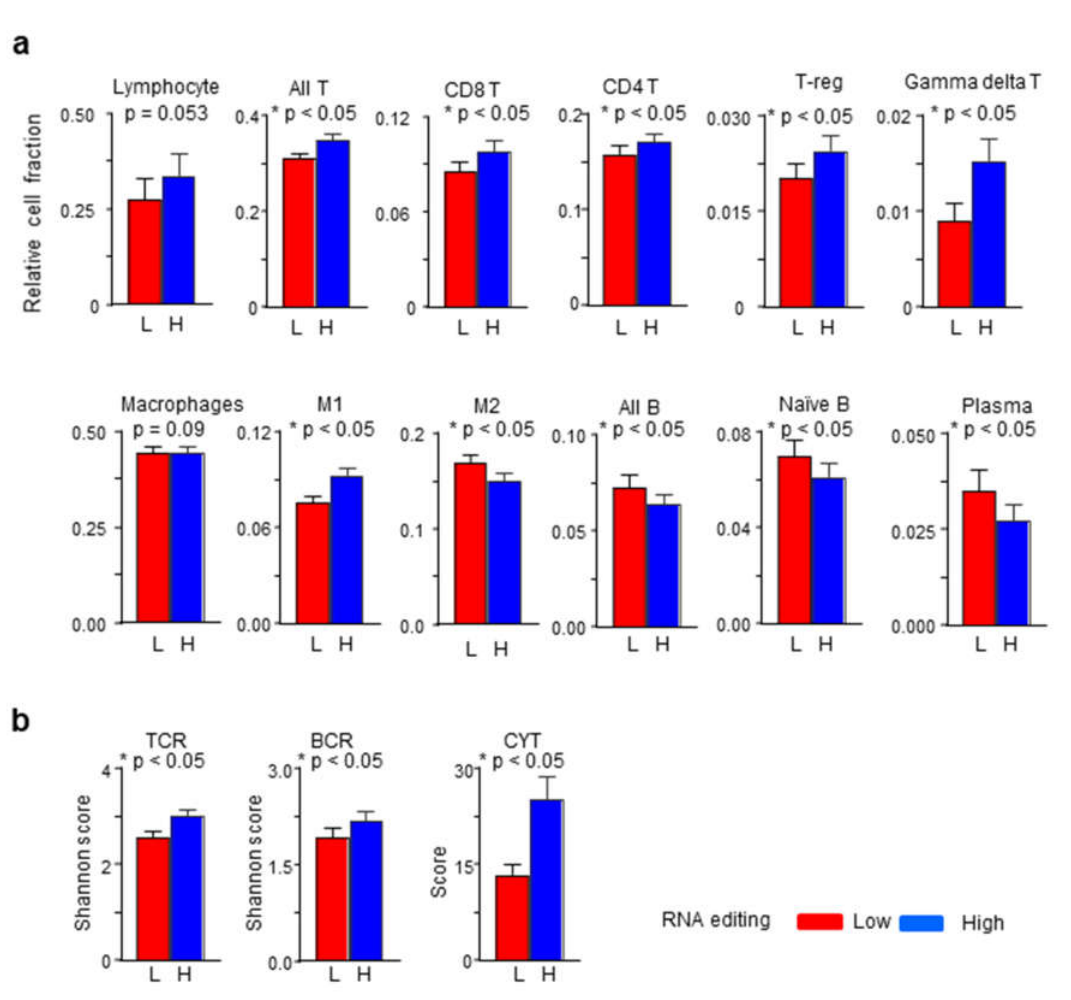
Figure 5. RNA editing and immune microenvironment features. Barplots of values for ( a ) relative fractions of tumor-infiltrating immune cells of different types and ( b ) T cell receptor (TCR) and B cell receptor (BCR) diversity (Shannon scores) and immune cytolytic activity (CYT score) are shown for the groups of RNA editing-high (H) and -low (L) tumors. The p -values in two-group comparisons were calculated with standard t -test.